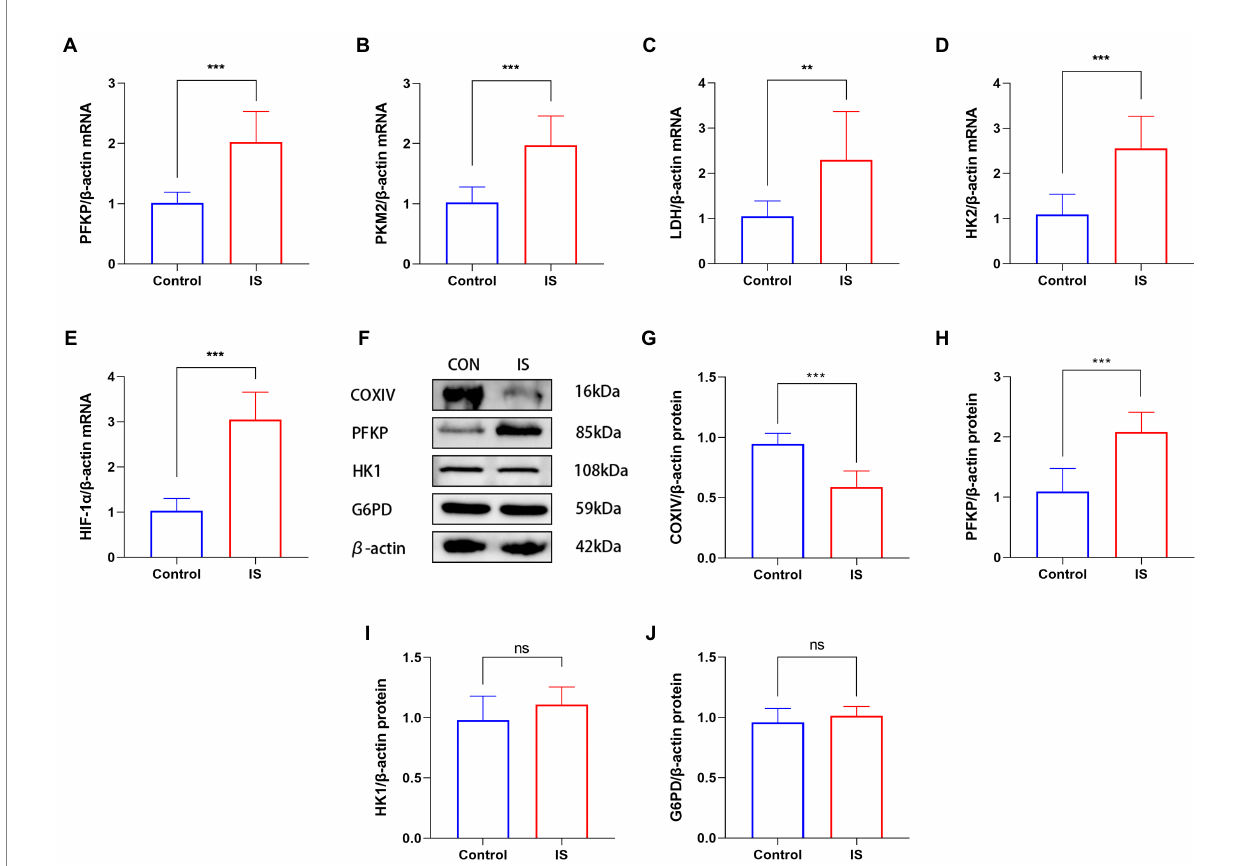
FIGURE 1 IS dural infusion induced the upregulation of glycolysis in the medulla dorsal horn. (A–E) Real time quantitative polymerase chain reaction showed that compared with the control group, the expression of glycolysis related genes (including PFKP, HK2, PKM2, LDH and HIF-1 α ) in migraine model group increased. Data were expressed as mean ± SD ( n = 3 per group). ** p < 0.01, *** p < 0.001. (F) WB analysis of PFKP, COXIV, HK1 and G6PD protein levels in the medulla dorsal horn. (G) Quantification of the WB showed that the expression of COXIV protein in the medulla dorsal horn of IS group was lower than that of the CON group. Data were expressed as mean ± SD ( n = 3 per group). *** p < 0.001. (H) IS dural infusion enhanced PFKP protein levels in the medulla dorsal horn. Data were expressed as mean ± SD ( n = 3 per group). *** p < 0.001. (I) Quantification of the WB showed no significant difference in HK1 protein expression in the medulla dorsal horn. Data were expressed as mean ± SD ( n = 3 per group). (J) Quantification of the WB showed no significant difference in G6PD protein expression in the medulla dorsal horn. Data were expressed as mean ± SD ( n = 3 per